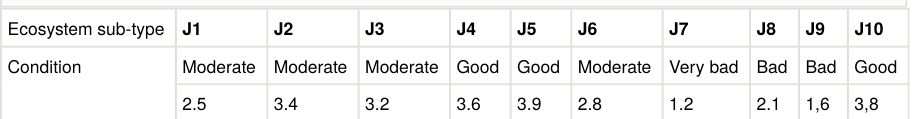
Condition of urban ecosystem subtypes based on the integrated index of spatial structure.